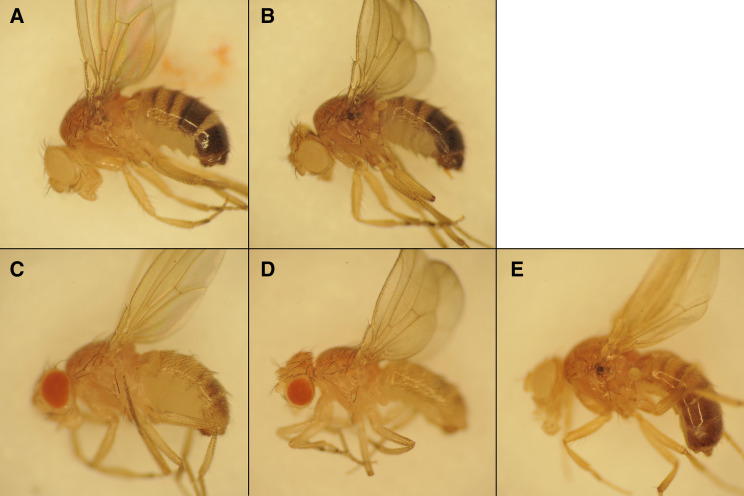
The Bombyx mori aaNAT gene can rescue speck mutations, but causes decreased pigmentation. Adult males are shown with anterior to the left and dorsal up. A.) A male heterozygous for the AANAT1MB02738 allele shows wild type pigmentation (w1118; AANAT1MB02738/+). B.) The speck phenotype is observed in the AANAT1MB02738/speck2 genotype (w1118; AANAT1MB02738/SM6a) C.) Ubiquitous misexpression of the Bombyx mori aaNAT gene causes a loss of pigmentation (w1118; AANAT1MB02738/+; TubulinGAL4, UAS-Bm-aaNAT/+) D.) Ubiquitous misexpression of the Bombyx mori aaNAT rescues the speck phenotype (w1118; AANAT1MB02738/SM6a; TubulinGAL4, UAS-Bm-aaNAT/+). E.)The speck phenotype in the wing hinge is still visible in genotypes that reduce pigmentation, such as yellow. (y*w*; bw1, speck1, zip2/SM6a).